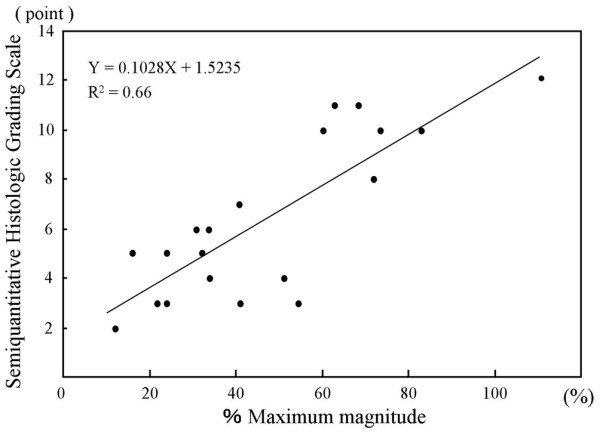
Scatter plot of ultrasound findings in rabbits with cartilage defects treated with cell/scaffold implants. The percentage maximum magnitude is expressed as the maximum magnitude of the measurement area in the operated knee, divided by that of the intact cartilage of the opposite, nonoperated knee.